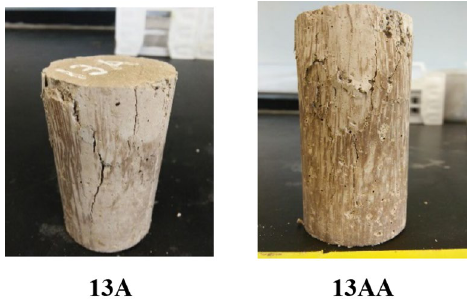
Fig. 2 Cement sample of 13 ppg after a compressive strength test at 60 °C and 90 °C